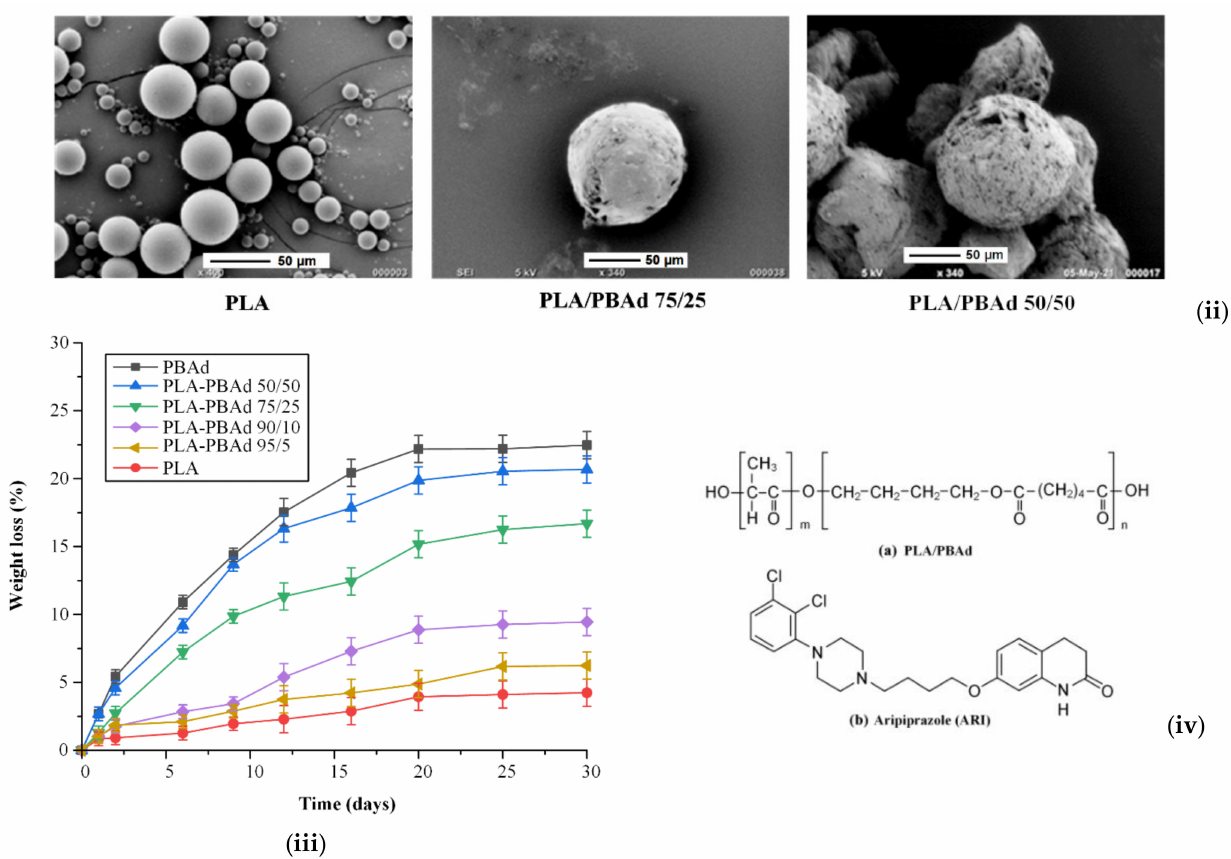
Figure 17. ( i ) Comparison of experimental release data (symbols) to the mechanistic model-based (continuous lines). ( ii ) SEM images of the polyester erosion process after 30 days of dissolution. ( iii ) The enzymatic hydrolysis profile measured as % weight loss vs. time plots for the neat PBAd, the neat PLA, and the various PLA/PBAd block copolymers. ( iv ) Chemical structures of prepared PLA/PBAd copolymer and aripiprazole drug